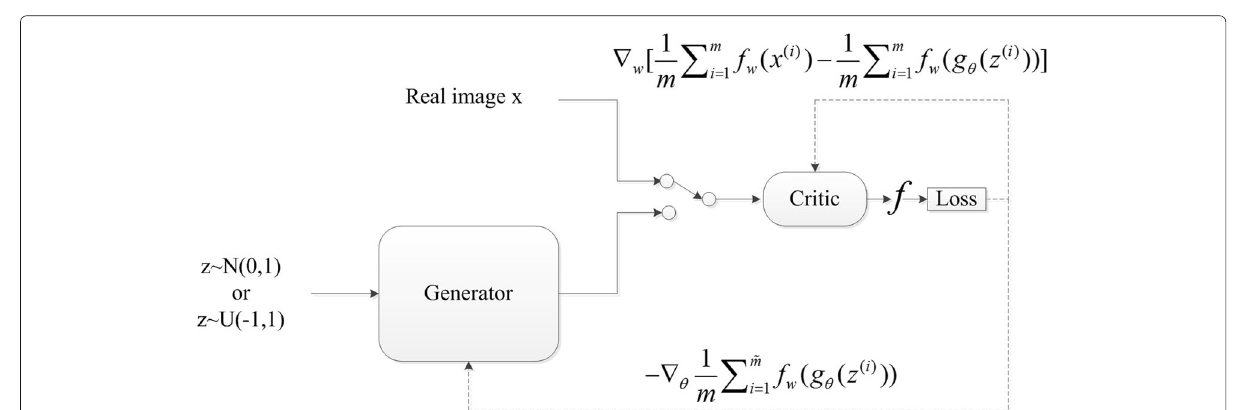
Fig. 2 Structure of Wasserstein